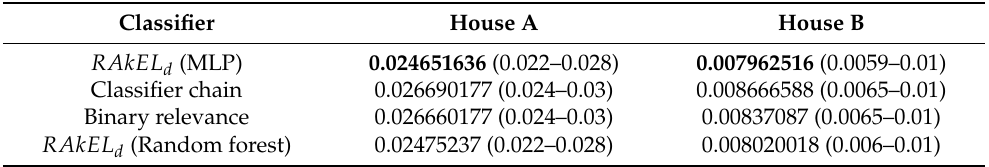
Table 7. Average Hamming loss per classifier (lower is better) trained on an unbalanced dataset. Inside the parentheses is the confidence interval (96% confidence). The best value can be seen in